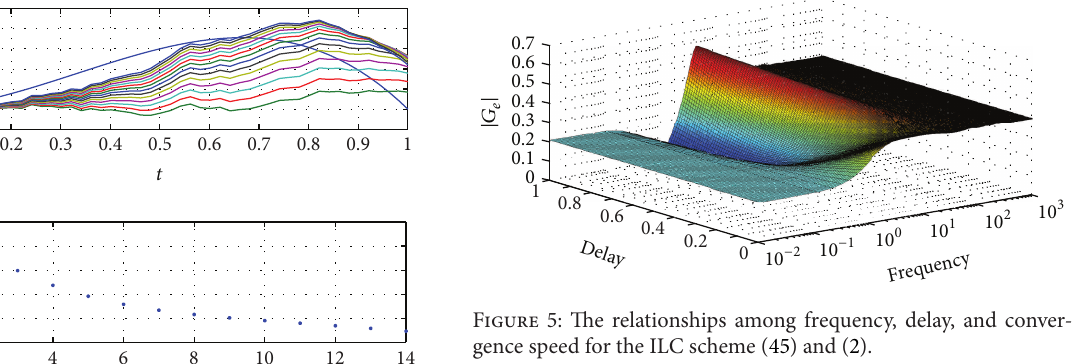
(𝑡) and 𝜔 (𝑡) are random 𝑘 𝑘